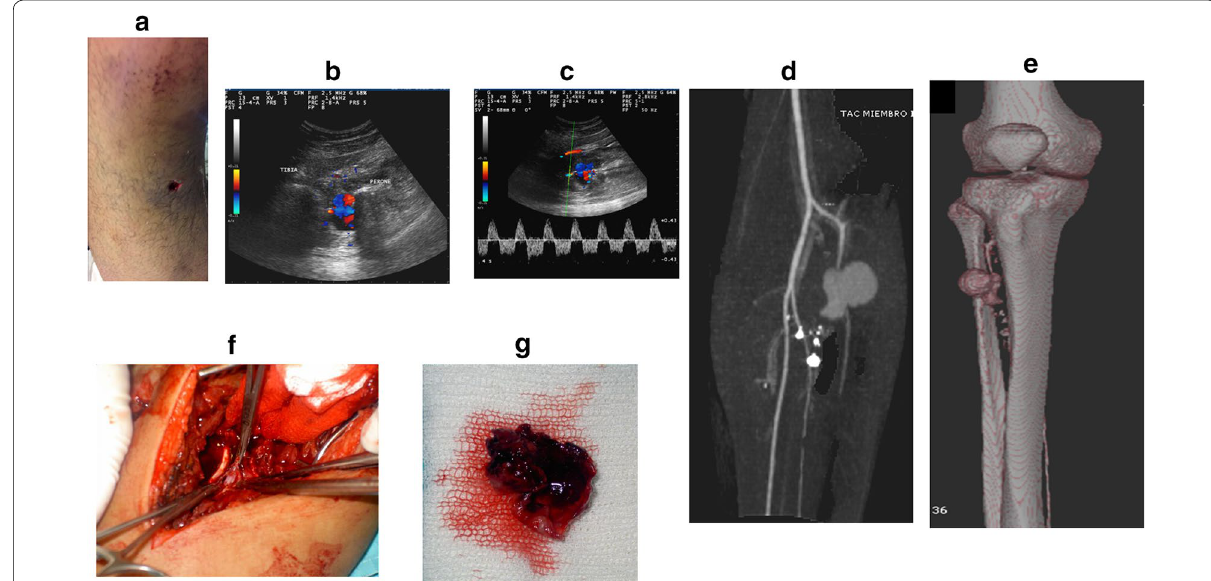
Fig. 16 Pseudoaneurism: Gun shot gun wound in the right leg with an arterial tibial pseudoaneurism. a Penetrating wound, b pseudo aneurism: color Doppler, c pulsed Doppler with the sample volume at the neck of the pseudoaneurism: bidirectional flow (to and fro), d CT angiography showing the pseudoaneurism and the metallic foreign bodies, e CT: 3D reconstruction, f surgical repairment, g intraoperative photography of the resected pseudoaneurysm